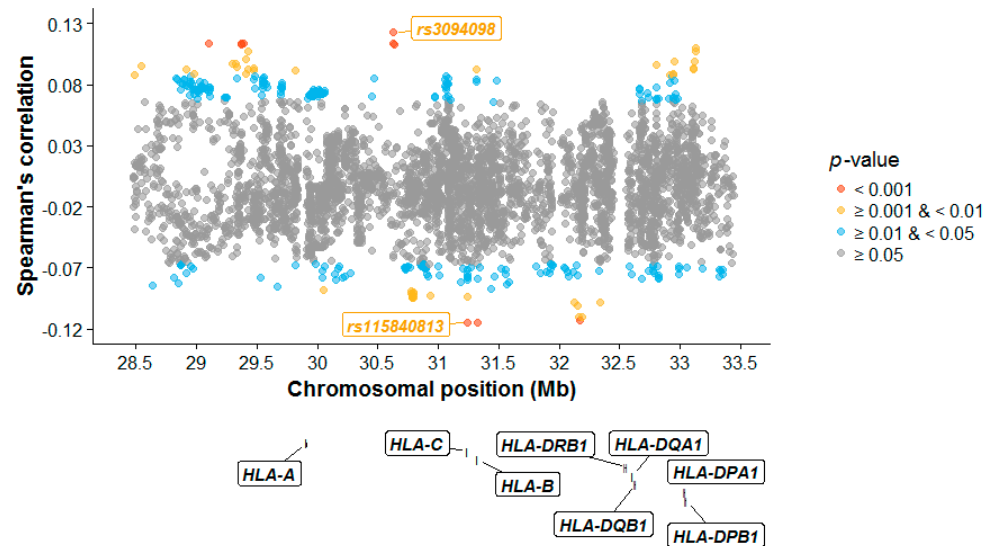
Figure 3. MHC correlation plot. The Spearman’s rank correlation coefficient ( ρ ) between spouses at each SNP is plotted against its physical chromosomal position. All nominally significant SNPs (based on two-sided p -values and before correction for multiple comparisons) are plotted in colour. The positions of the classical HLA genes are from UCSC (GRCh37/hg19) and superimposed in the plot.